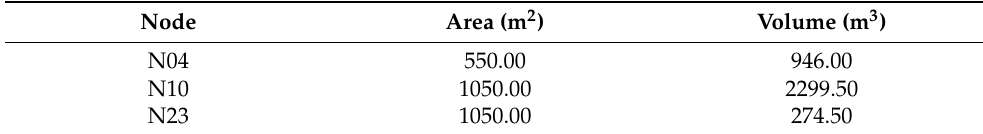
Table 6. Area and volume required in STs.